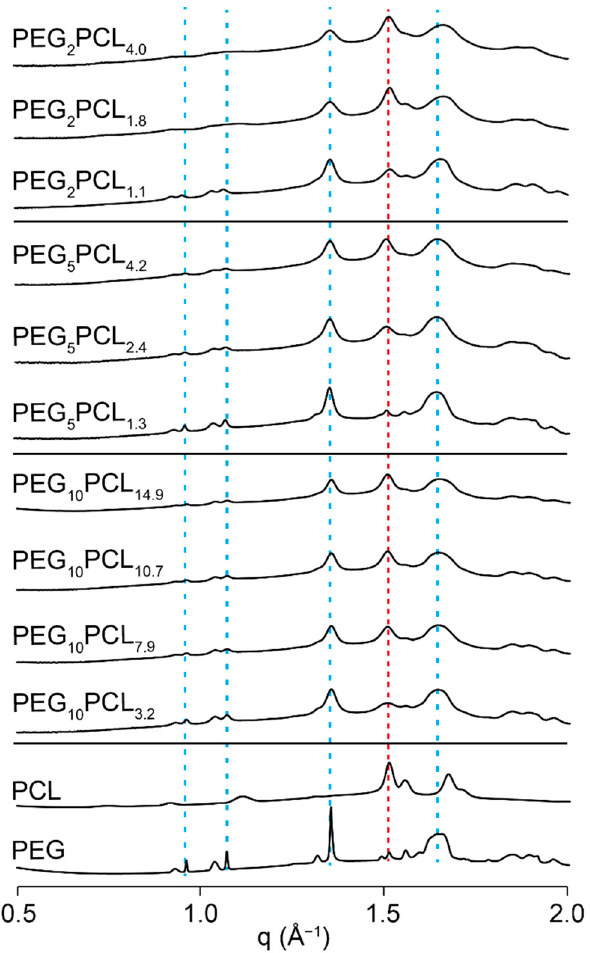
Figure 8. WAXS scattering profiles of the PEG 2 PCL y , PEG 5 PCL y , and PEG 10 PCL y copolymer micelles (lyophilised powder), and PEG 5 and PCL 2 homopolymers.